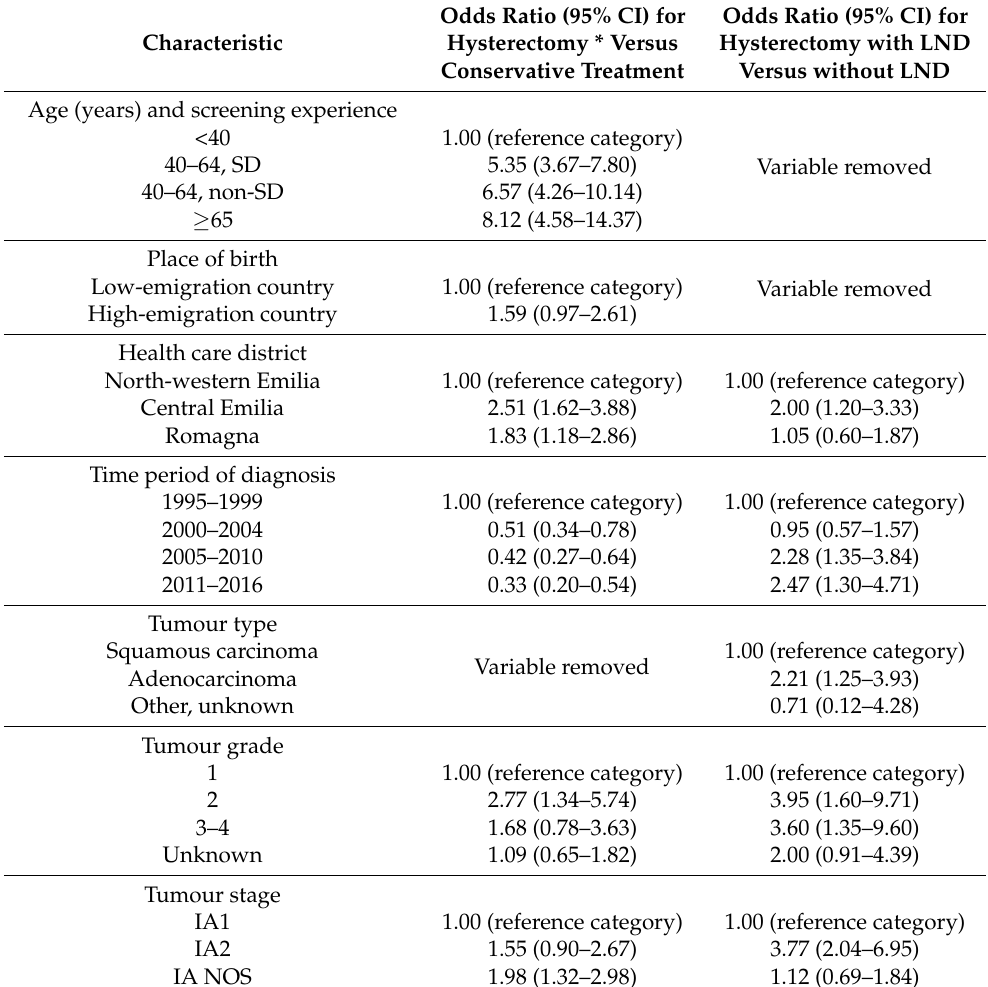
Table 4. Multivariate association of the registered patient and disease characteristics with the likelihood of hysterectomy—versus conservative treatment—and the likelihood of hysterectomy with—versus without—lymph node dissection in the treatment of stage IA cervical carcinoma. Emilia-Romagna Region, Italy